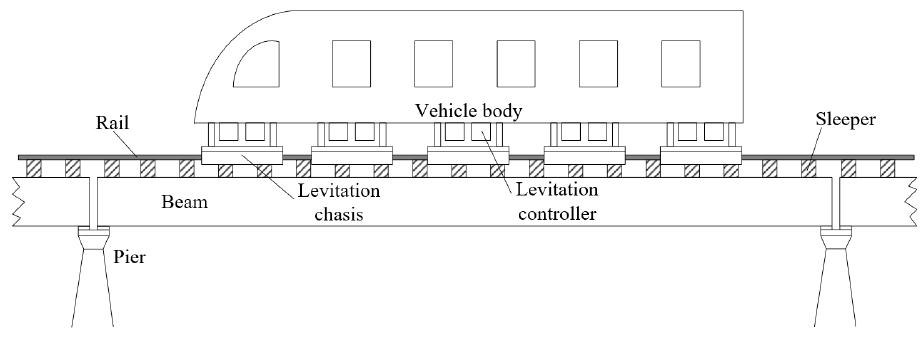
Figure 1. Maglev train on an operation line.